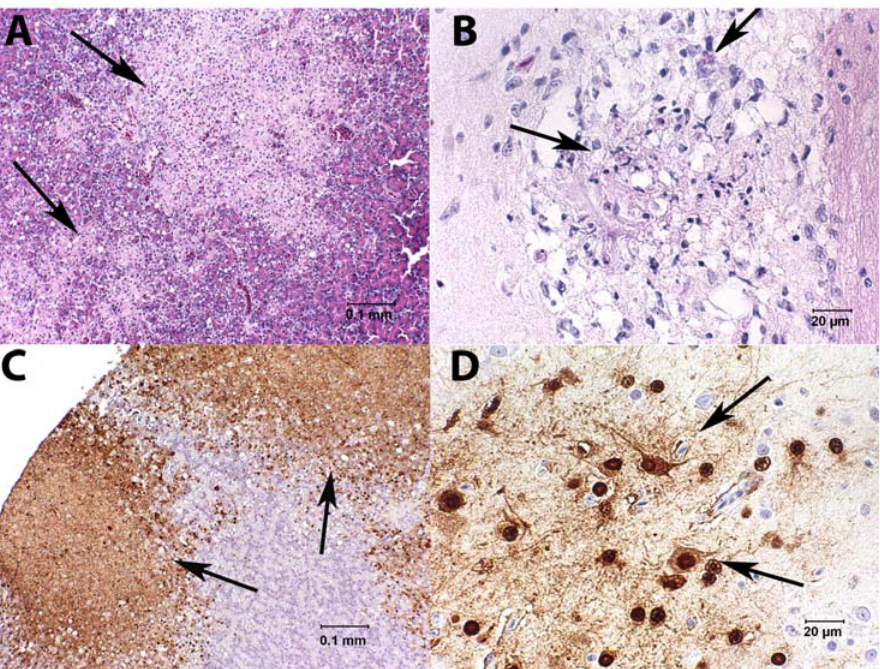
Figure 2. Tissues from American kestrels experimentally inoculated with highly pathogenic avian influenza virus H5N1. A. Pancreas with multifocal to coalescing areas of necrosis (arrows) (HE stain). B. Brain with multifocal cerebral necrosis (arrows) accompanied by a mild infiltration of heterophils (HE stain). C. Section of same pancreatic tissue as in Fig. 2A, stained by immunohistochemistry to identify influenza A virus antigen. Staining of influenza A antigen is intense in areas of necrosis (arrows). D. Immunohistochemical staining of influenza A virus antigen in brain tissue. Areas of brain necrosis are strongly positive (arrows).